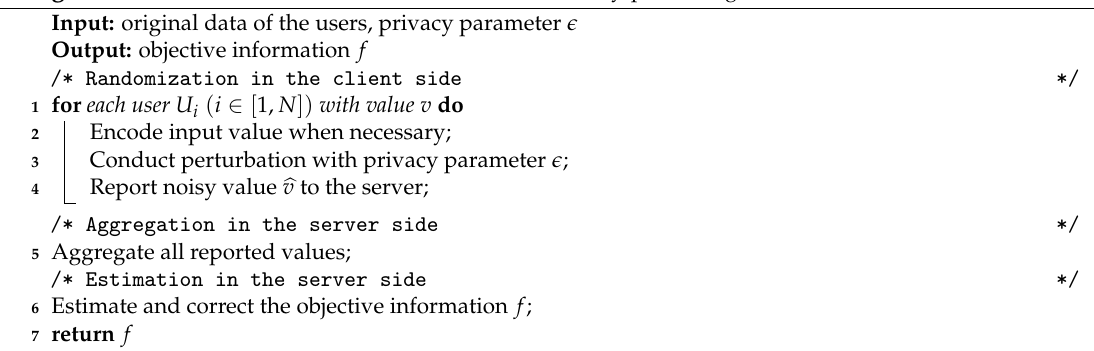
Algorithm 1: The General Procedure of LDP-based Privacy-preserving